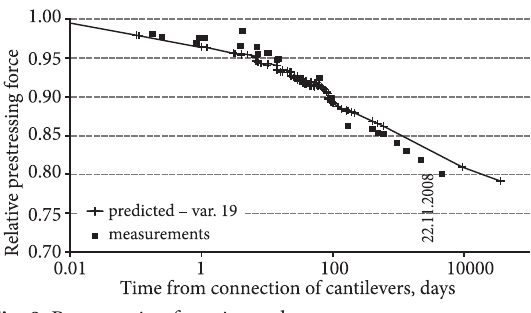
fig. 7. Relative deflection at mid-span caused by differential shrinkage